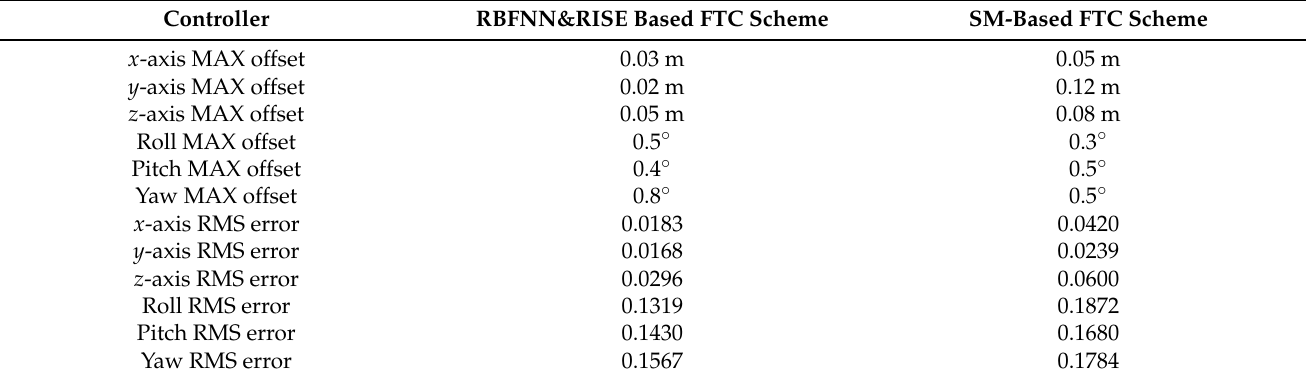
Table 1. Analysis of Control